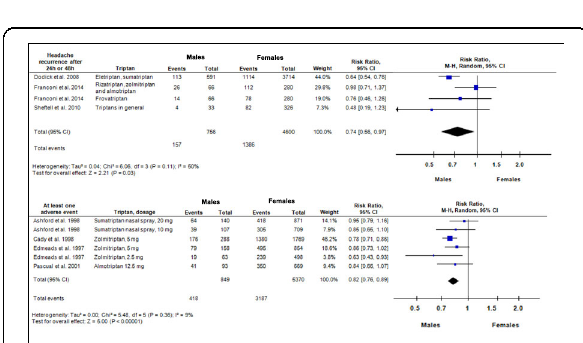
Fig. 2 (abstract P85). Forest plots of headache recurrence rate after 24 hours or 48 hours and the incidence of at least one adverse event after the intake of a triptan in male and female migraine